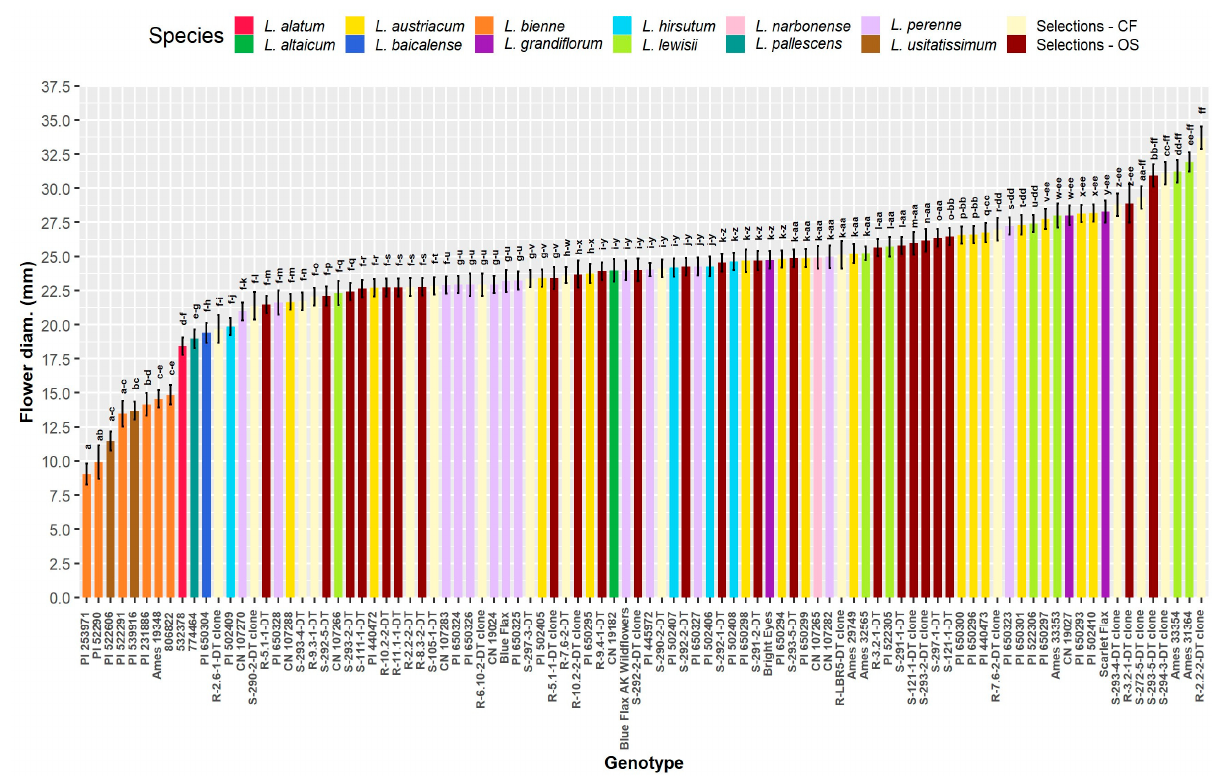
Figure 2. Mean ± S.E. flower diameter (mm) for all wild species, CF and OS flax (Linum) genotypes with n ≥ 3 observations. Means separations (5% HSD) are displayed as letters above the columns denoting significance.